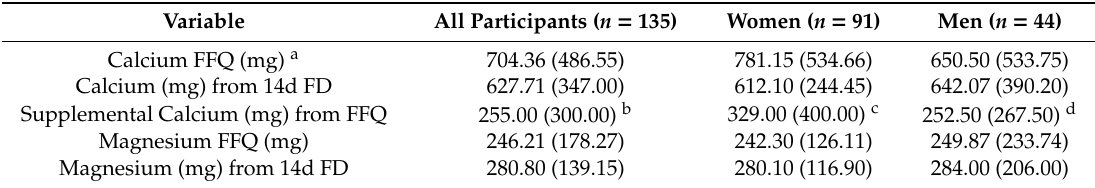
Table 4. Magnesium and calcium intakes calculated from the food frequency questionnaires and the 14-day food